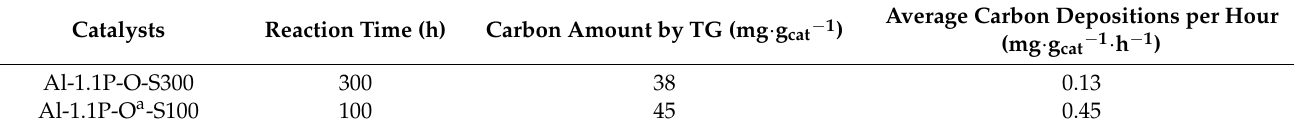
Table 3. The textural properties of Al- x P-O and Al-1.1P-O a samples. Catalysts